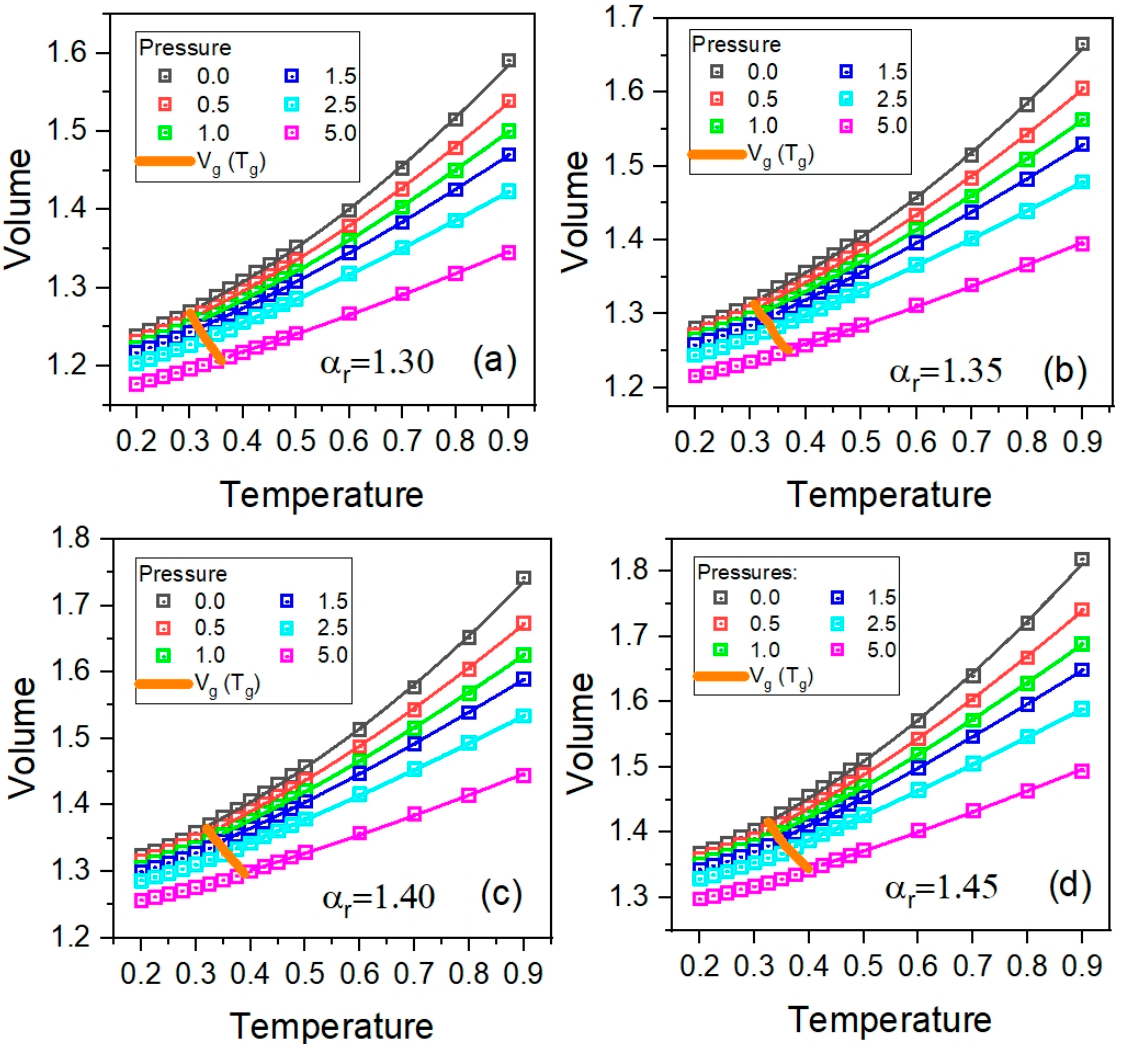
Figure 1. The plots of the isobaric dependences of the particle number volume V on temperature T in the glassy and supercooled liquids states in the GB model, which are presented in the panels for the different anisotropy aspect ratios α r : ( a ) 1.30, ( b ) 1.35, ( c ) 1.40, and ( d ) 1.45, respectively. The solid curves crossing the isobaric dependences V on T denote the glass transition curves and the solid curves along the dependences V ( T ) present the fitting curves to the EoS given by Equation (3) with the values of its fitting parameters collected in Table 1.